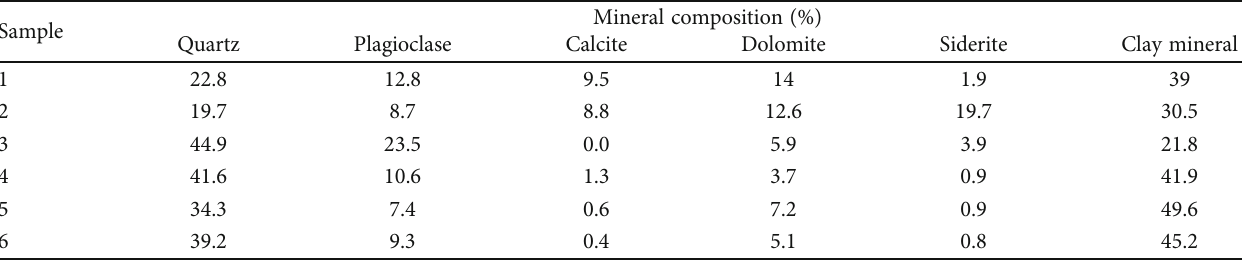
Figure 1: Shale sample from Bohai oil fi eld. Table 1: Mineral composition and content.